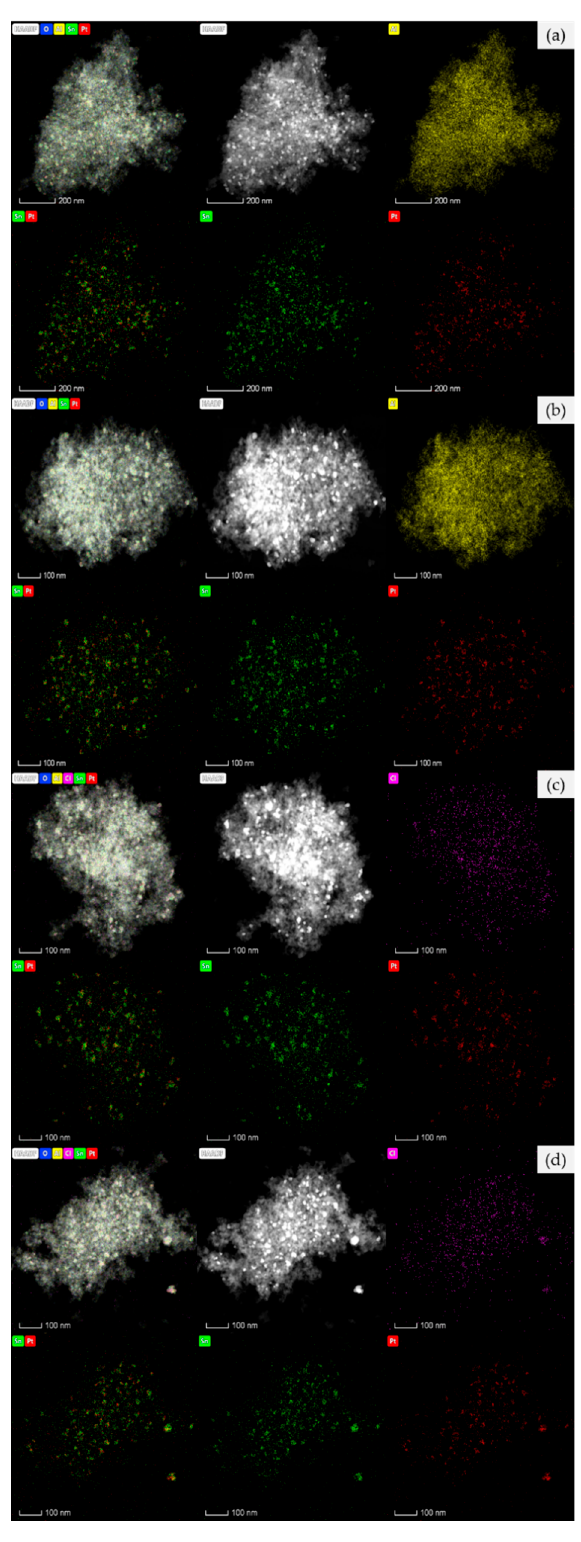
Figure 4. Energy dispersive X-ray (EDX) element mapping images of ( a ) reduced PtSn-C, ( b ) reduced PtSn-B, ( c ) reduced PtSn-B-HCl5, and ( d ) reduced PtSn-B-HCl35.